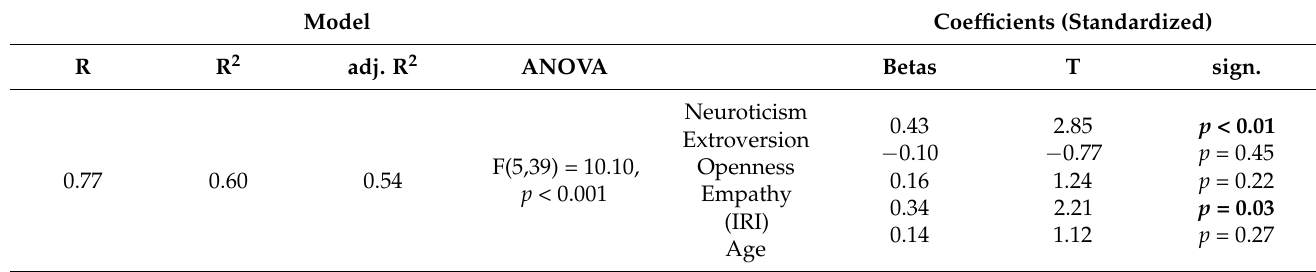
Table 5. Regression analyses of SPS with personality measures as predictors (significant results in bold).